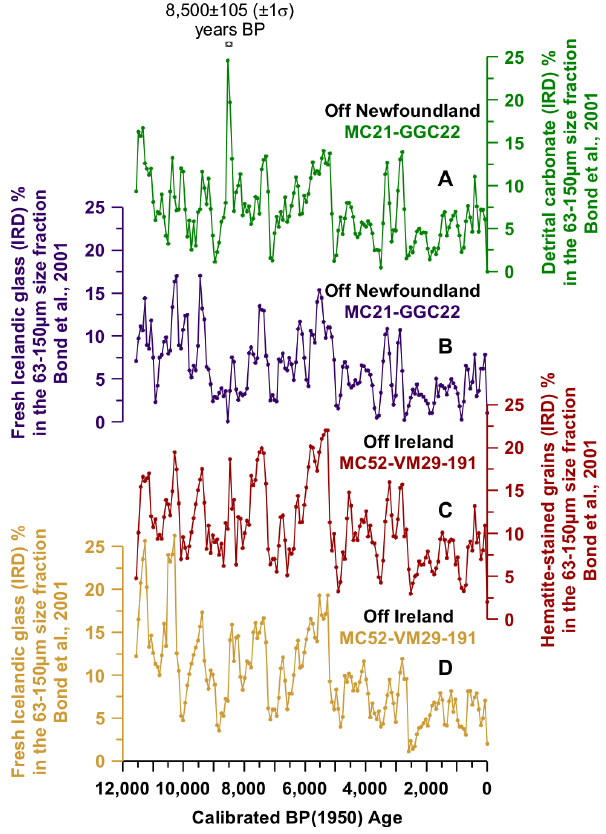
Figure 8. The unique maximum in drift ice off Newfoundland around 8500 ± 105years BP. Percentages of (a) detrital carbonate and (b) fresh Icelandic volcanic glass in the 63–150µm size frac- tion of sediment cores MC21-GGC22 (off Newfoundland). Note the prominent maximum in the detrital carbonate record, while the percentages of fresh Icelandic volcanic glass drop to zero around 8500 ± 105years BP. Percentages of (c) hematite-stained grains and (d) fresh Icelandic volcanic glass in the 63–150µm size fraction of sediment cores MC52-VM29-191 (Rockall Trough, off Ireland) (Bond et al.,